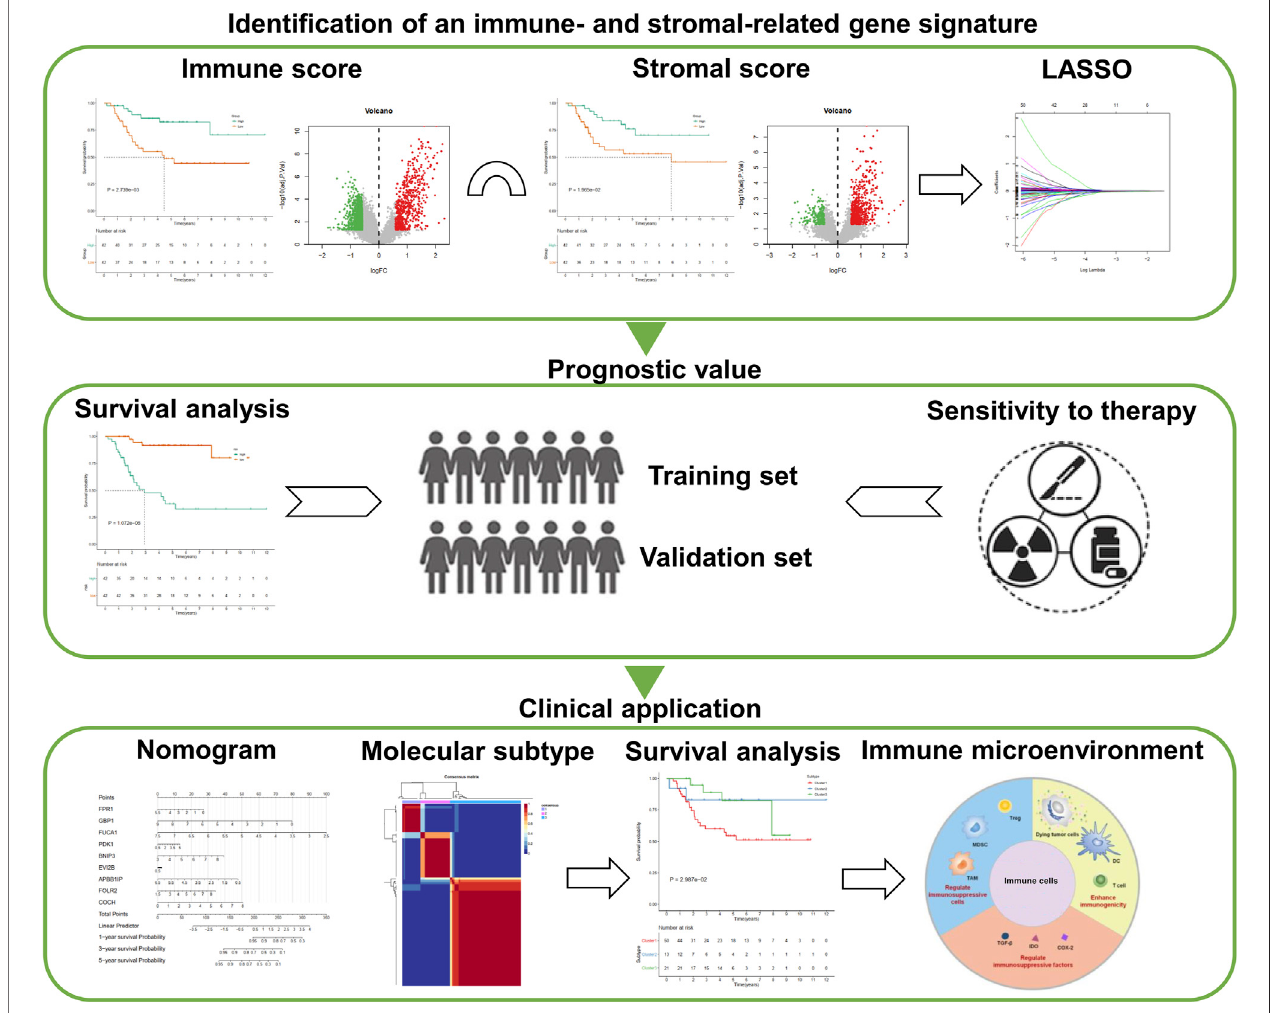
FIGURE 1 | Study design and work fl ow